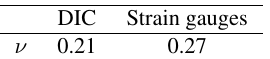
Table 2: Poisson’s ratio comparison for test n. 2.